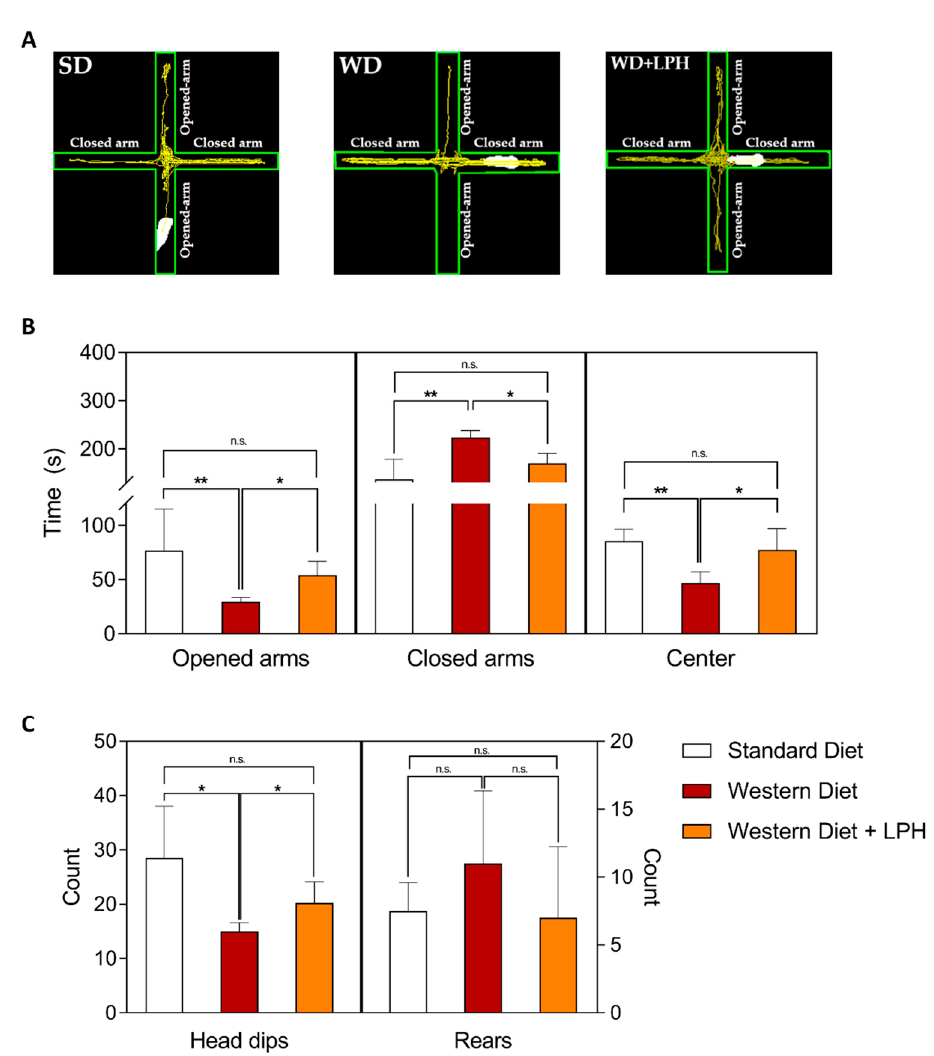
Figure 3. Representative images of the tracks of mice in the elevated plus maze ( A ). Time spent in opened arms, closed arms, and center zone ( B ), head dips and rears ( C ). Values are shown as the mean and standard deviation of each group. * p ≤ 0.05; ** p ≤ 0.01; n.s., not significant; SD, standard diet fed-mice; WD, Western diet-fed mice; WD + LPH, Western diet-fed mice treated with LPH; LPH, lupin protein hydrolysate.